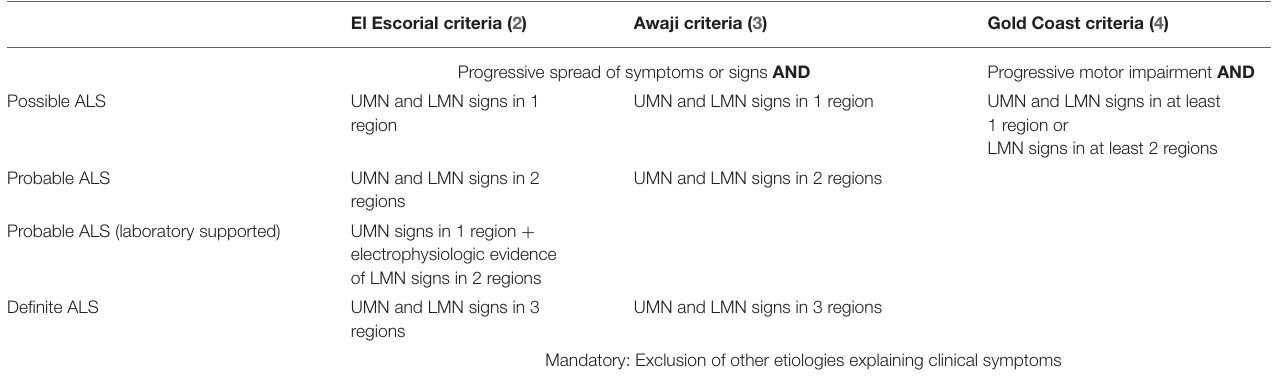
TABLE 1 | Comparison of the El Escorial (2), Awaji (3), and Gold Coast criteria (4) for Amyotrophic Lateral Sclerosis.